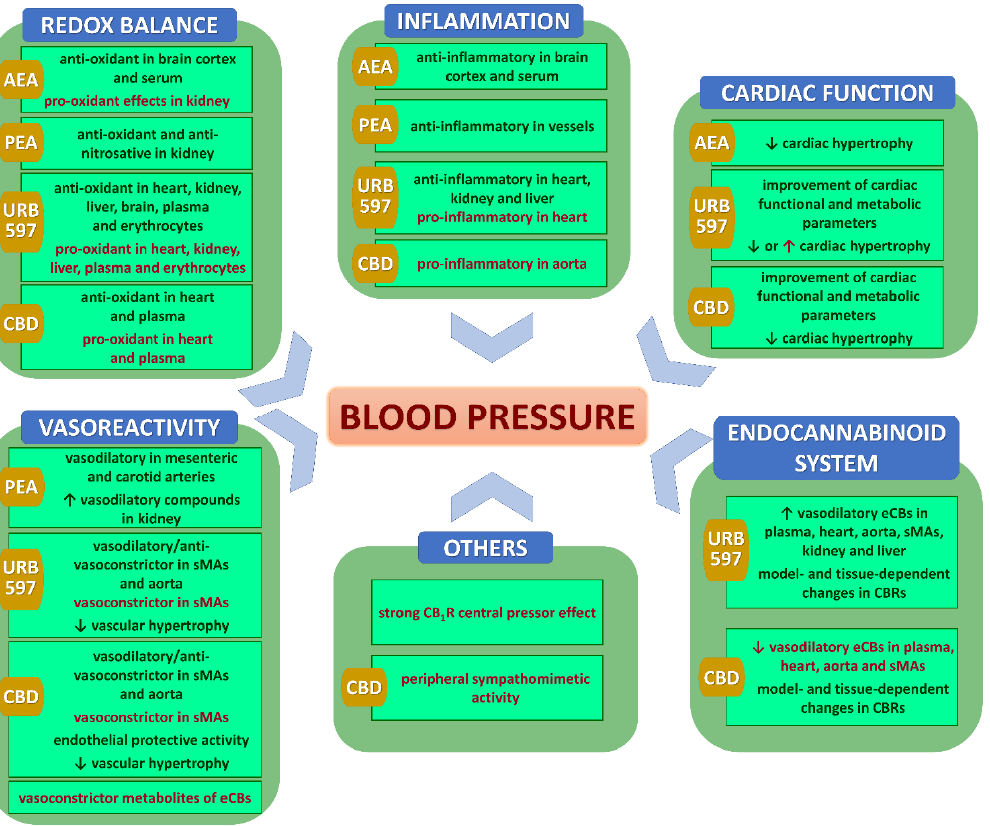
Figure 2. Summarized effects of multitarget (endo)cannabinoids on blood pressure. For clarity, the effects, listed in detail in Tables 3 and 4, are partly simplified and are based on results of all parameters connected with particular mechanisms, which sometimes were opposite. ↑ —increase; ↓ —decrease; AEA—anandamide; CBRs—cannabinoid receptors; CB 1 R—cannabinoid type 1 receptor; CBD—cannabidiol; eCBs—endocannabinoids; PEA—palmitoyl ethanolamide; sMAs—small mesenteric arteries.